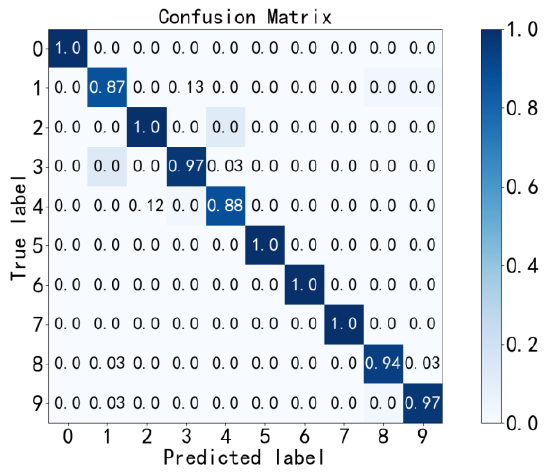
Figure 14. Fault diagnosis without the PE method.